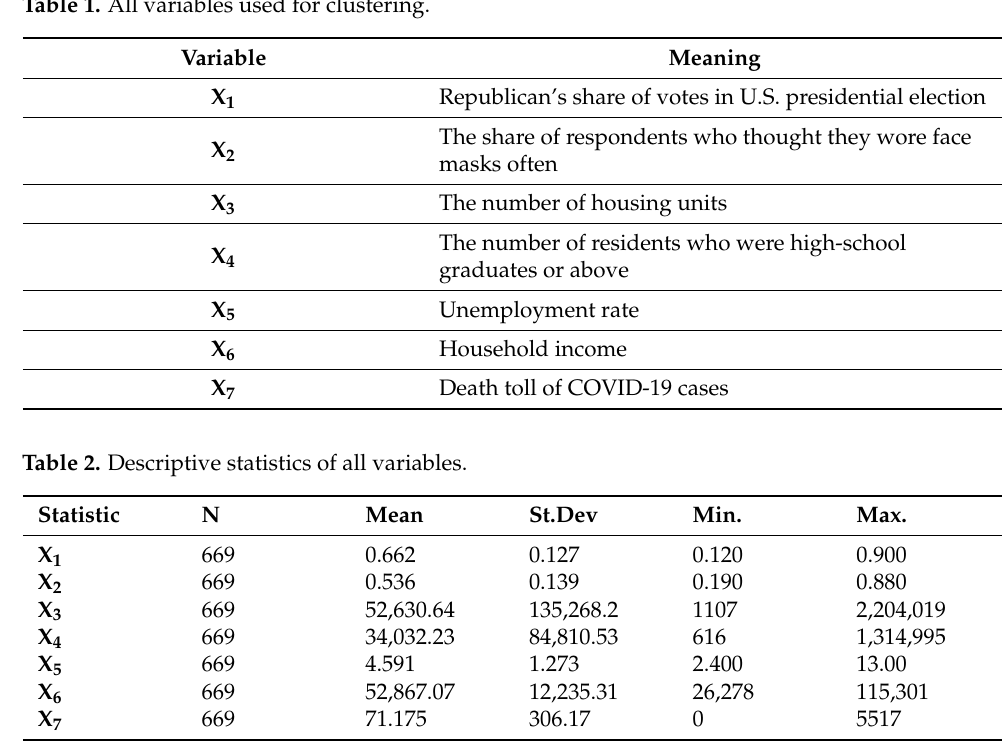
Table 1. All variables used for clustering.